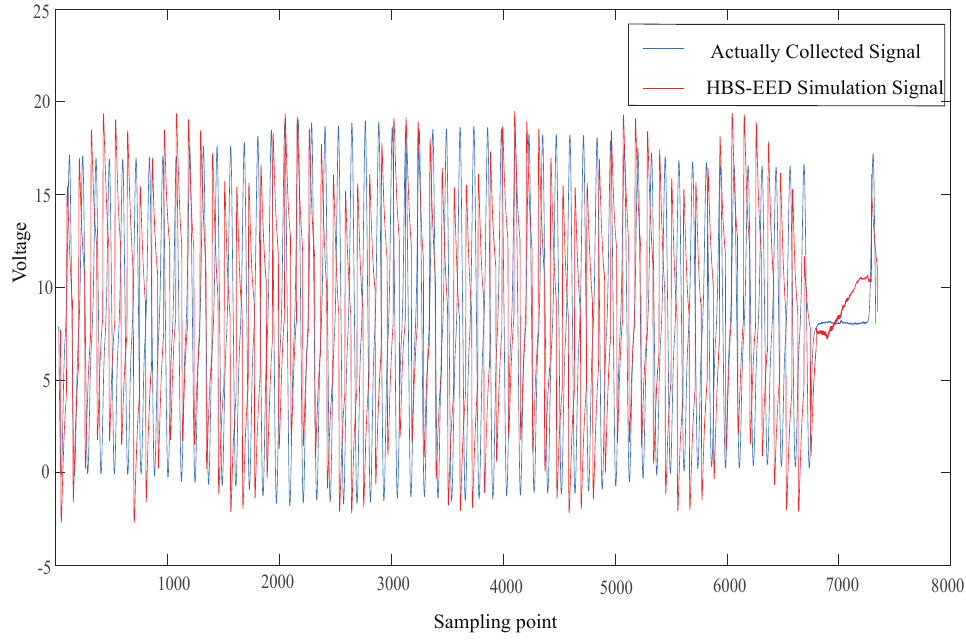
Figure 19. Comparison of the HBS-EED simulation and actually collected signal. In Figure 20, the blue curve represents the actually collected CKP signal. The red curve represents the MSS-AS simulation CKP signal. The signal simulated by the